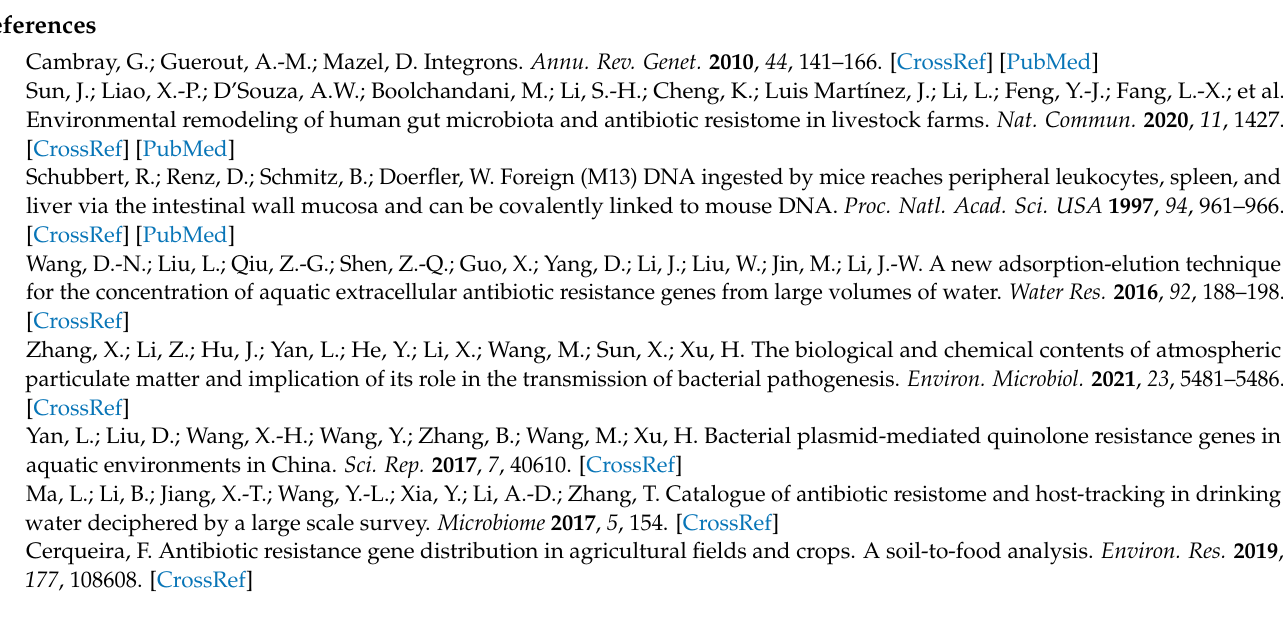
Figure S1: Melting curve for primers targeting sul2 ; Figure S2: Conjugative transfer of pR55 from E. coli C600 to S. enterica